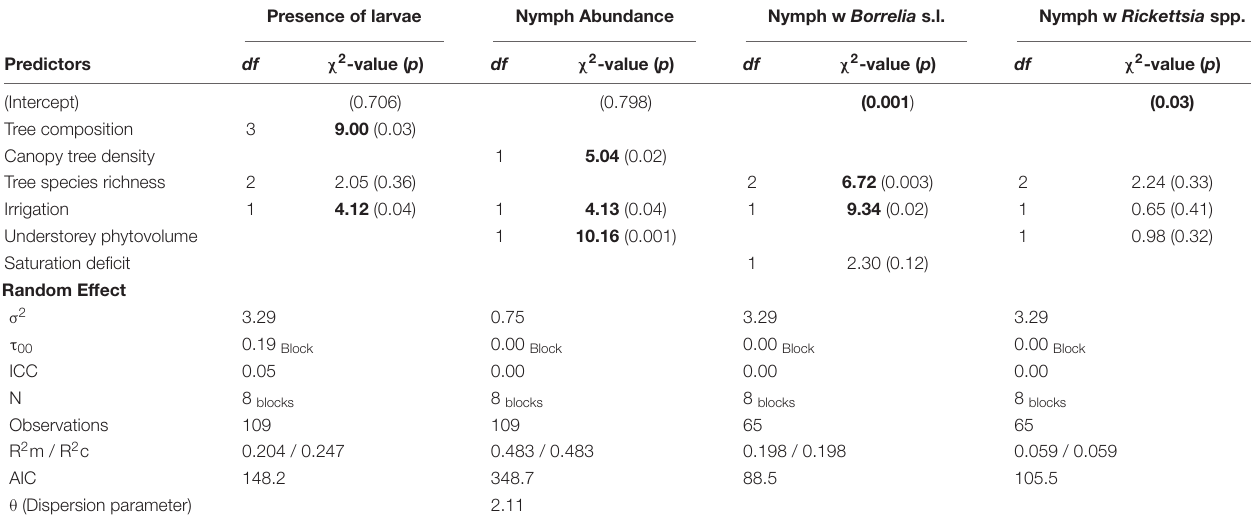
FIGURE 2 | Ixodes ricinus nymph abundance as a function of tree composition in all sampled plots, in irrigated plots (blue) and non-irrigated plots (red). Pp: Pinus pinaster, Bp : Betula pendula, Qr : Quercus robur, Qi : Quercus ilex. Dots and solid lines represents mean ± SE calculated on raw data. TABLE 2 | Summary of results of final negative binomial GLM models for Ixodes ricinus nymph abundance, binomial GLMMs for presence of larva and binomial logit model for proportion of infected nymph by Borrelia and Rickettsia pathogens. Presence of larvae Nymph Abundance Nymph w Borrelia